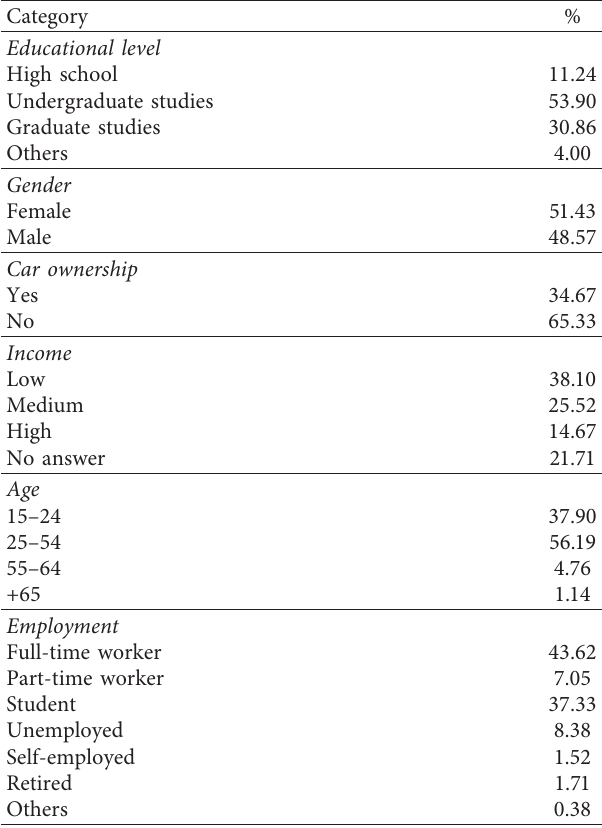
Table 1: The descriptive statistics of the sociodemographic and economic